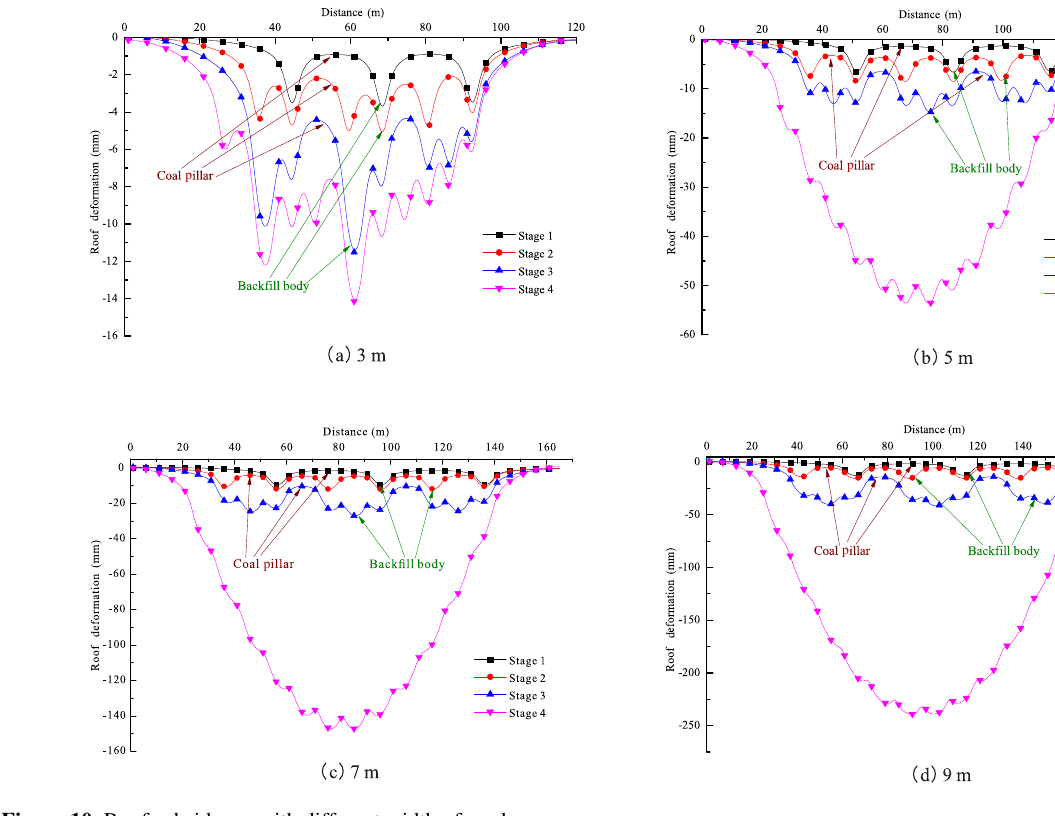
Figure 10. Roof subsidence with different width of